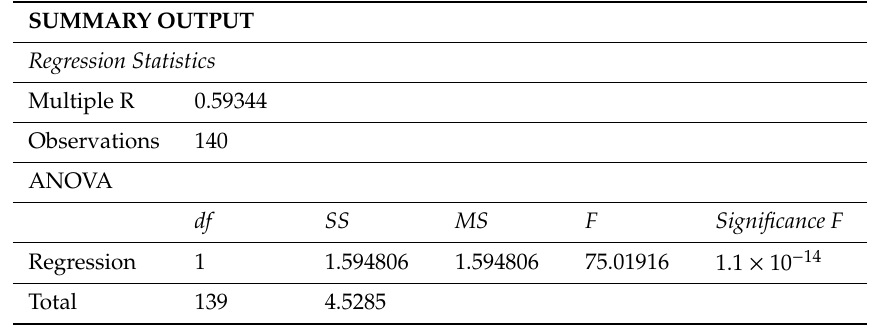
Table 5. Correlation—% share of civic sector representation and utilization of the Community planning of social services